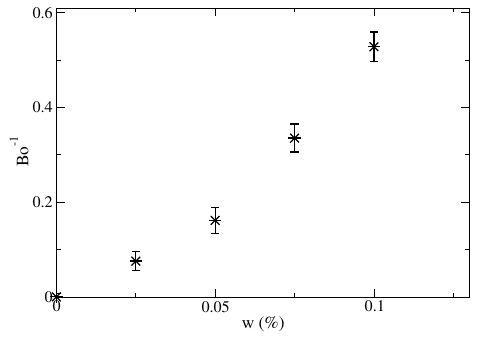
= F c / F p as a func- o